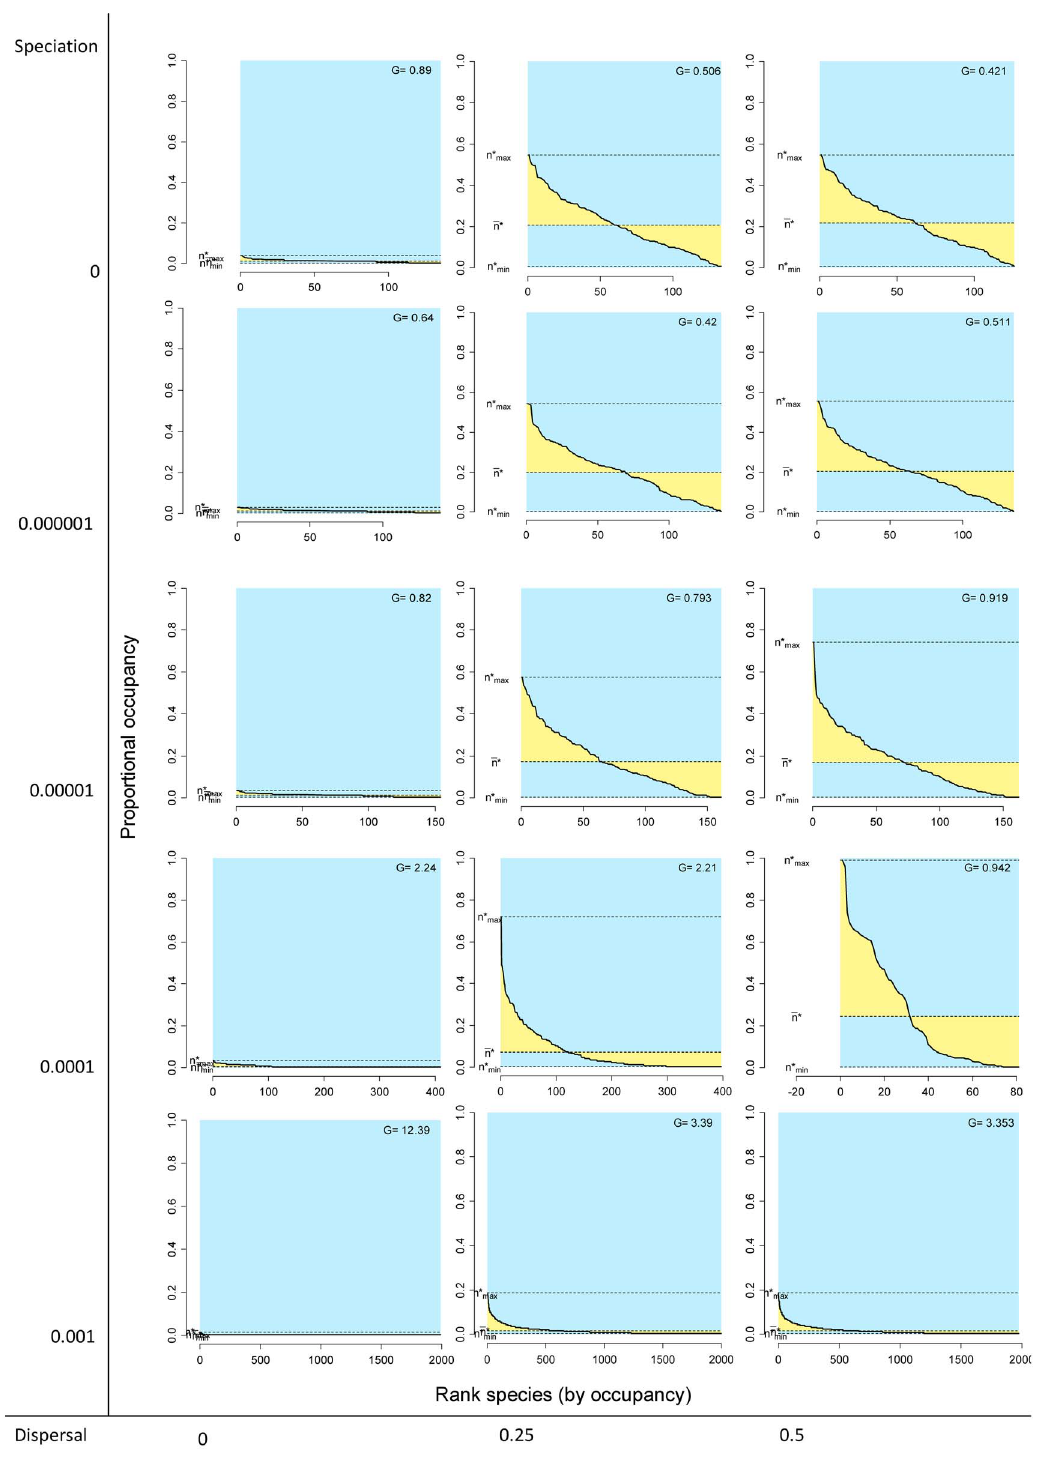
Figure 5. Rank distribution plots by species for different combinations of the speciation and dispersal parameters in neutral models. Information as in Figures 1 and 2C.